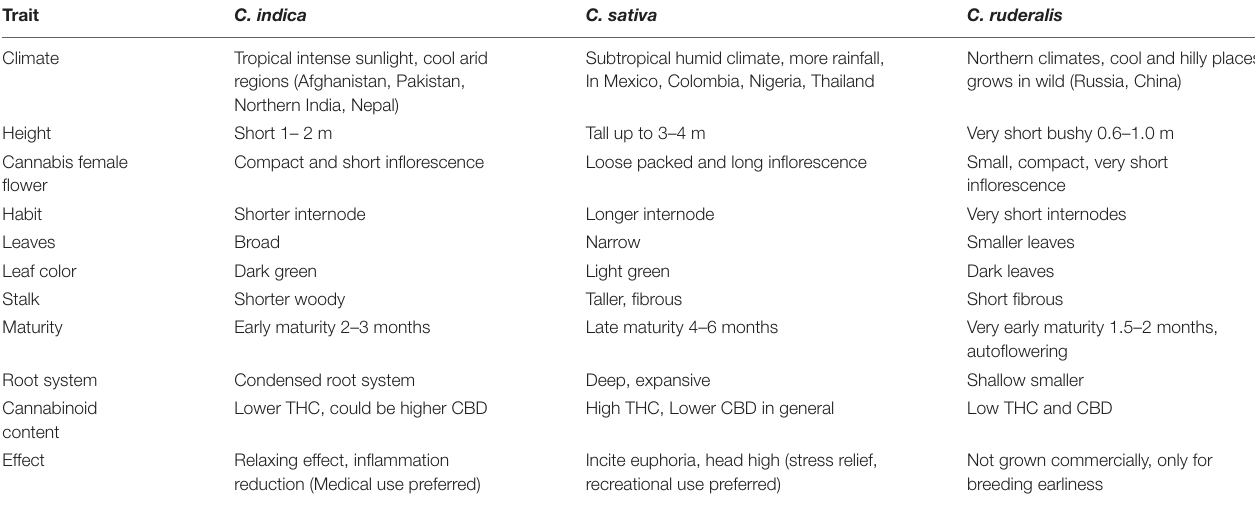
TABLE 1 | Phenotypic differences among C. indica, C. sativa , and C. ruderalis ecotypes.